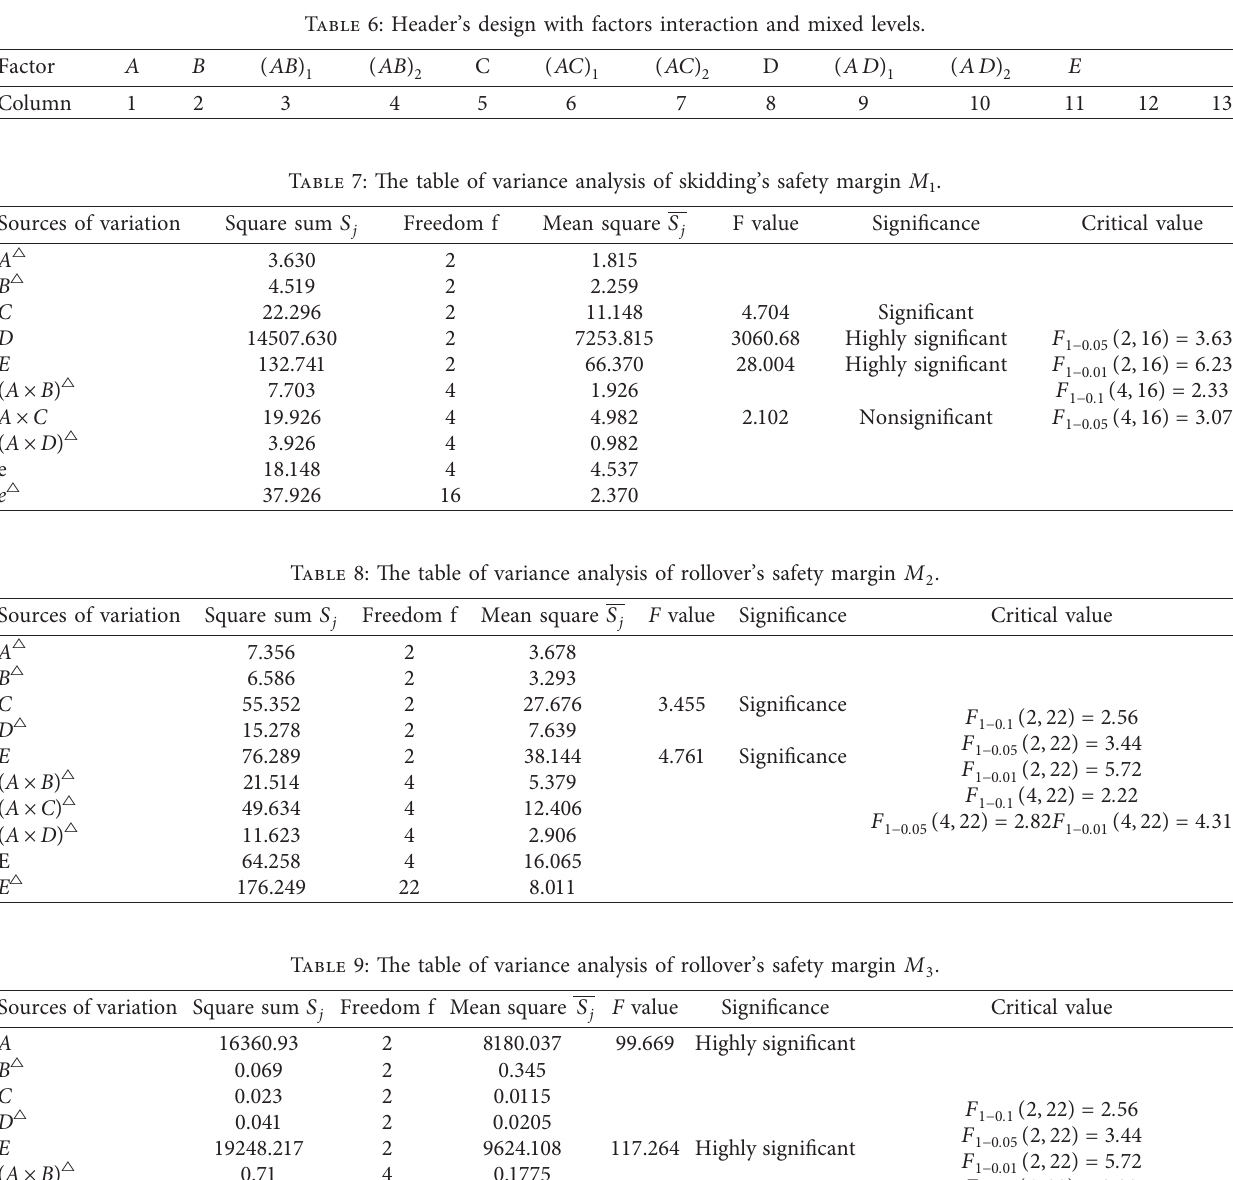
Table 6: Header’s design with factors interaction and mixed levels.